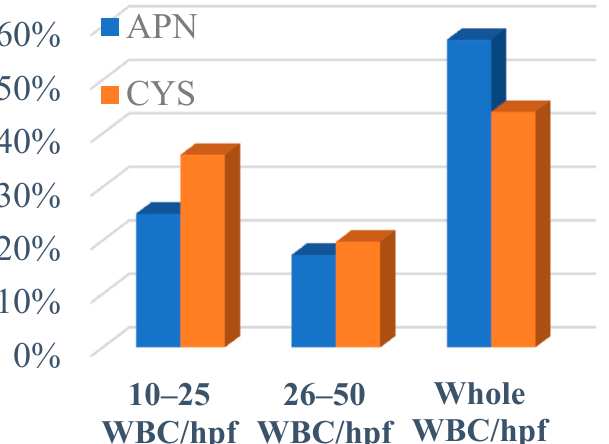
Figure 2. Pyuria in patients with APN and CYS. APN; acute pyelonephritis, CYS; cystitis, WBC/hpf; white blood cells per high power field.